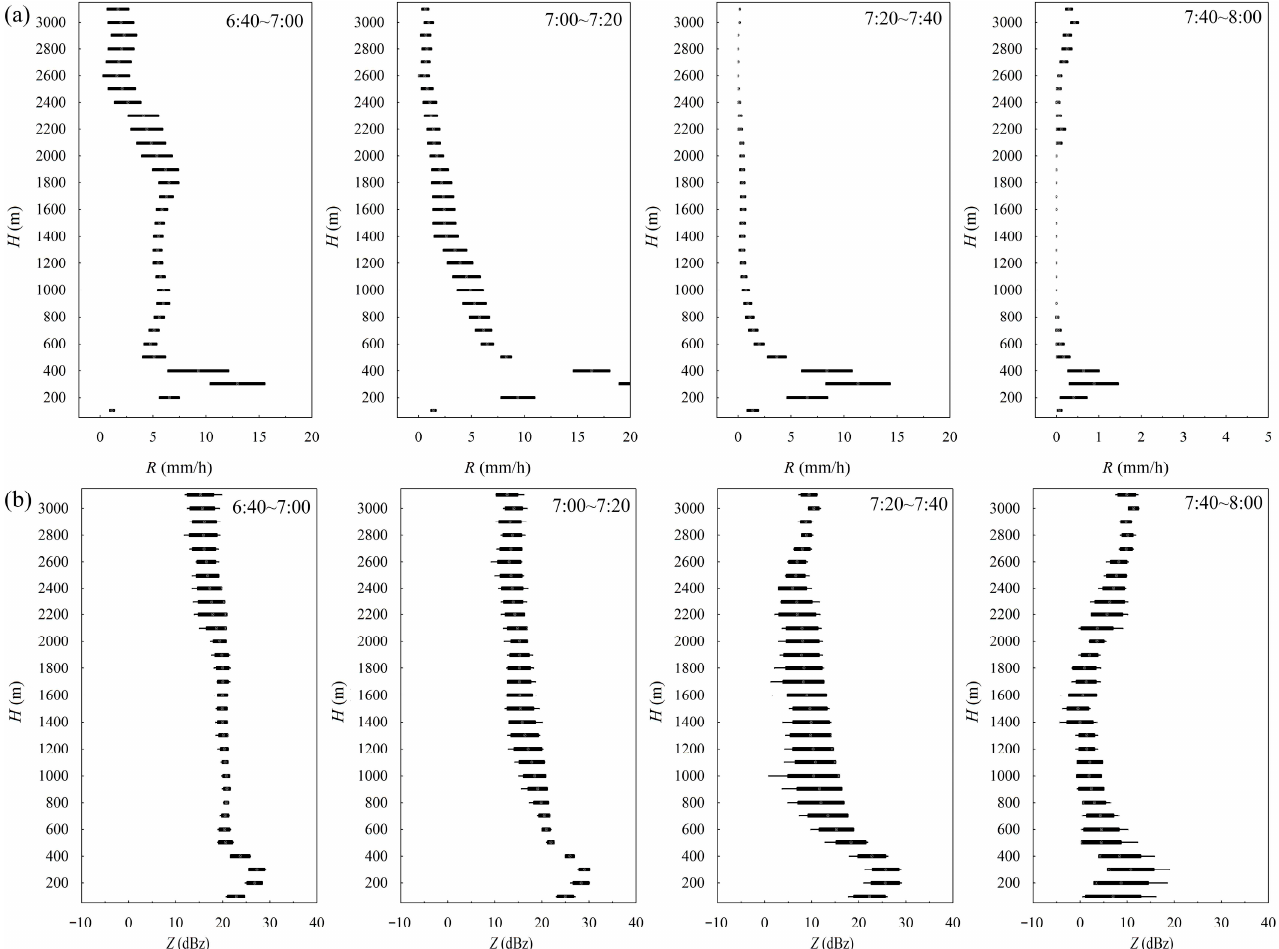
Figure 8. Temporal evolution of ( a ) R and ( b ) Z profiles measured by MRR in the zenith direction of the field site.